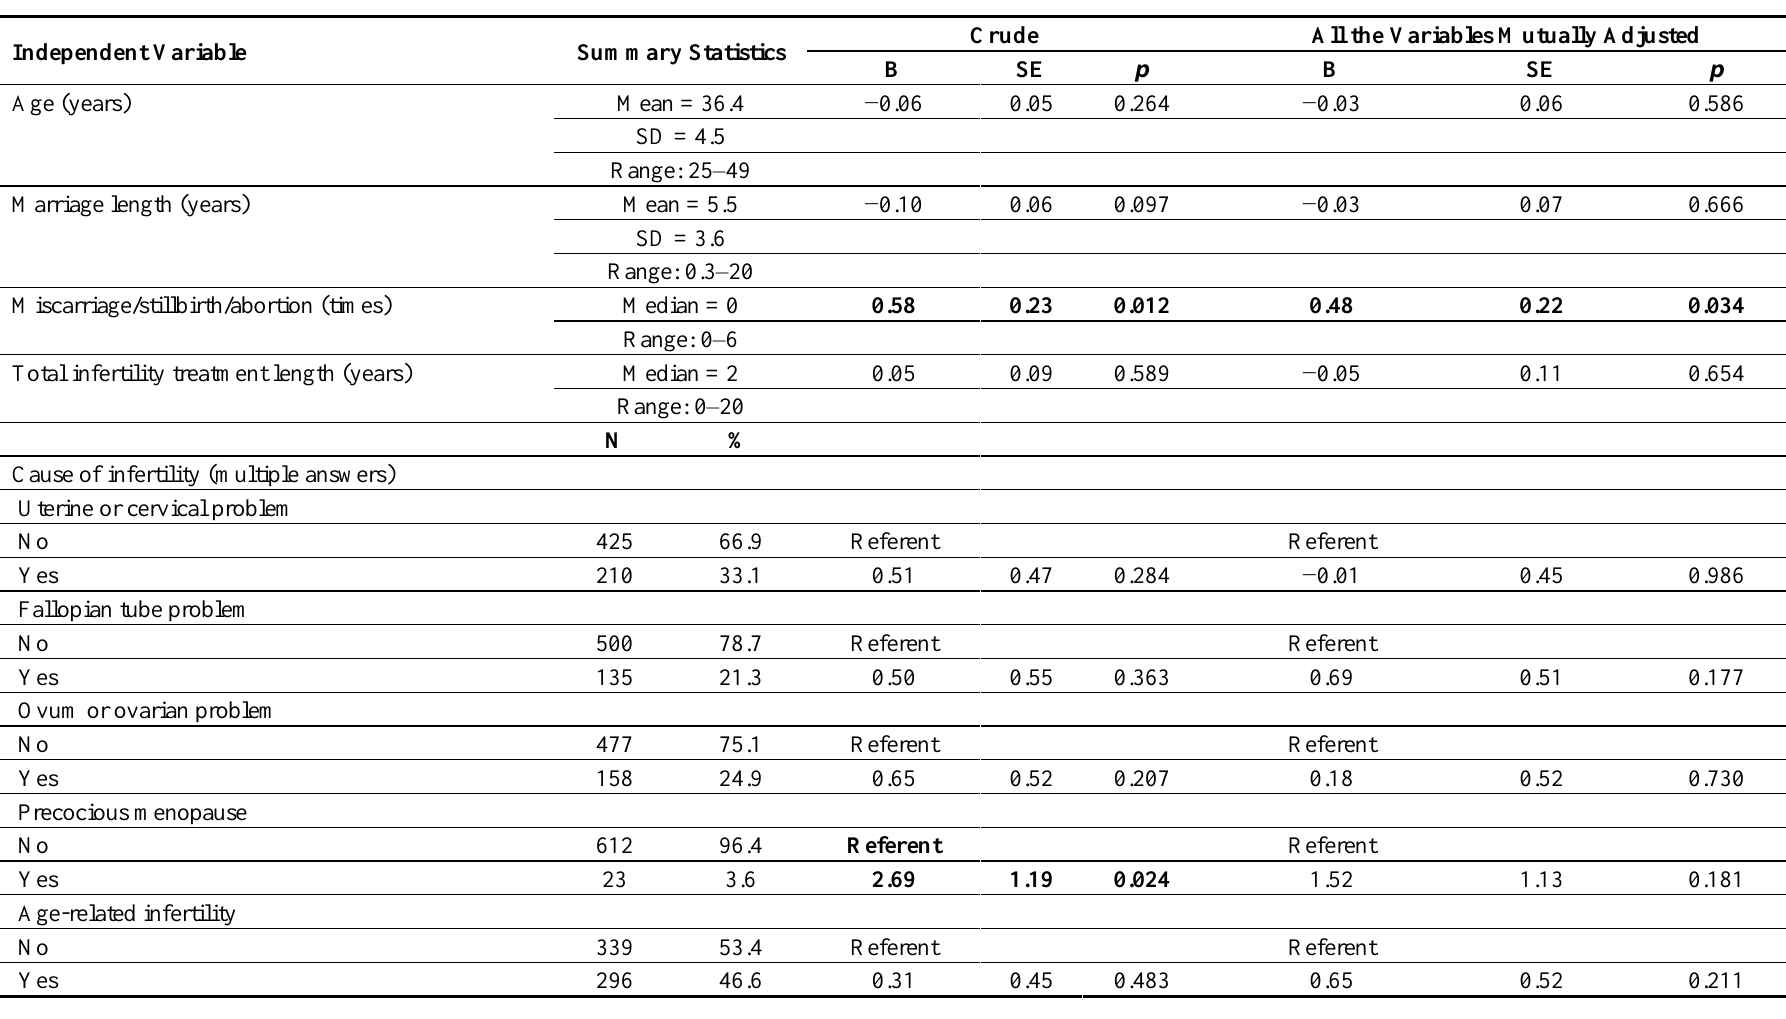
Table 2. Participant characteristics and results of linear regression analyses for the Kessler Six-question Psychological Distress Scale (K6) scores ( n =